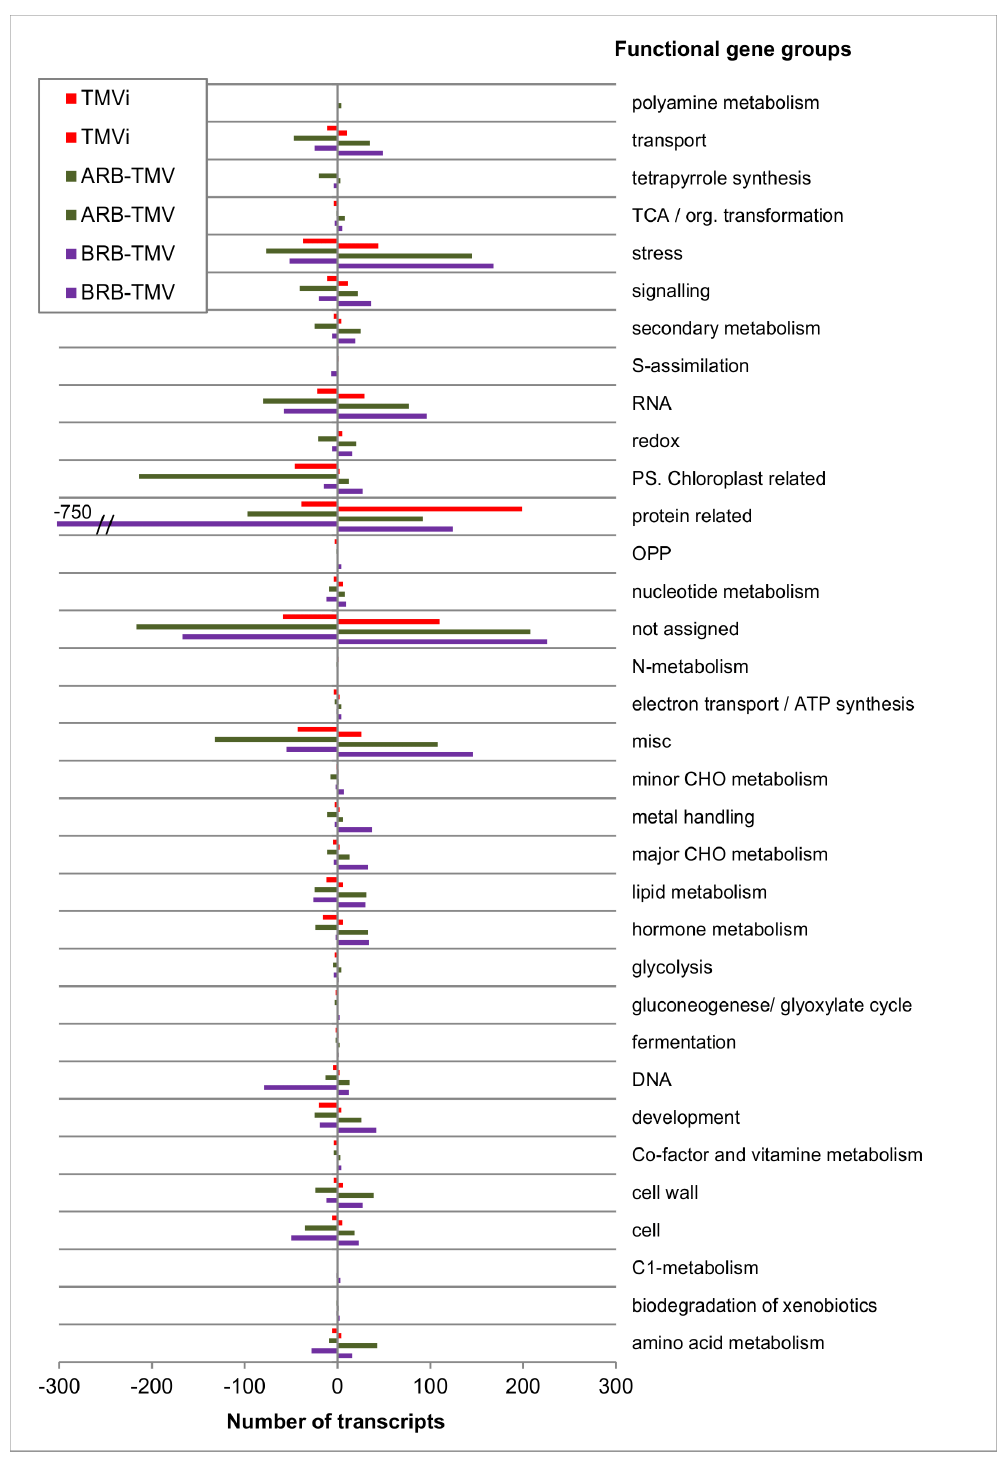
Figure 2. A overview chart showing the distribution in different functional groups of the up- and down-regulated transcripts and their numbers in the BRB- and ARB-TMV transgenic, and in TMVi tobacco plants.